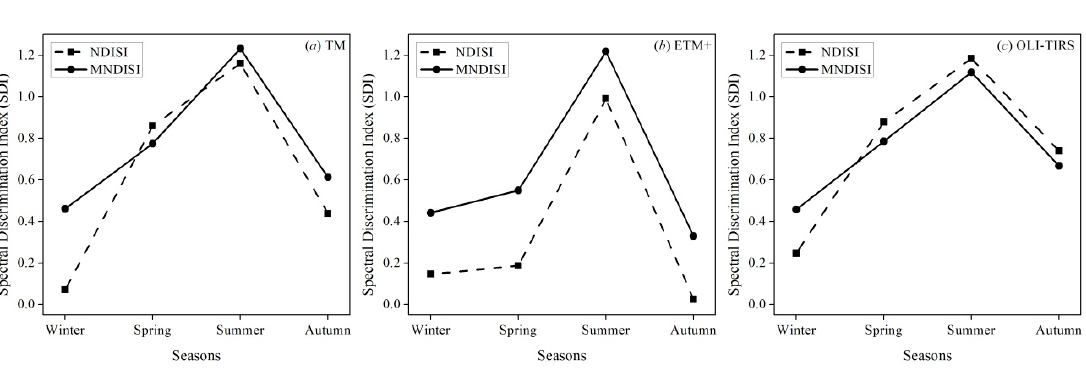
Figure 7. Comparison of seasonality between the MNDISI and NDISI using images from three sensors: ( a ) TM; ( b ) ETM+; and ( c ) OLI/TIRS.